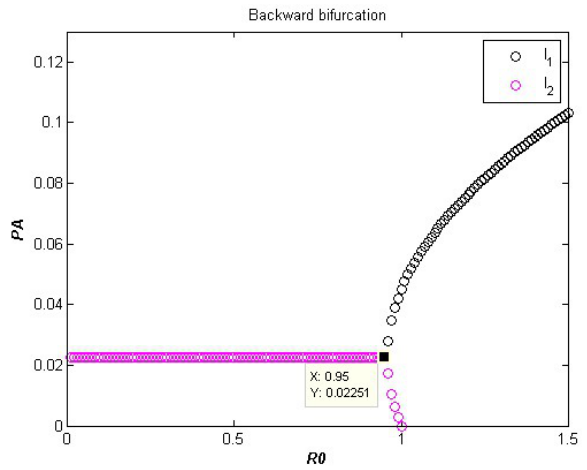
Figure 2. Pre-AIDS class at equilibria versus R 0 .